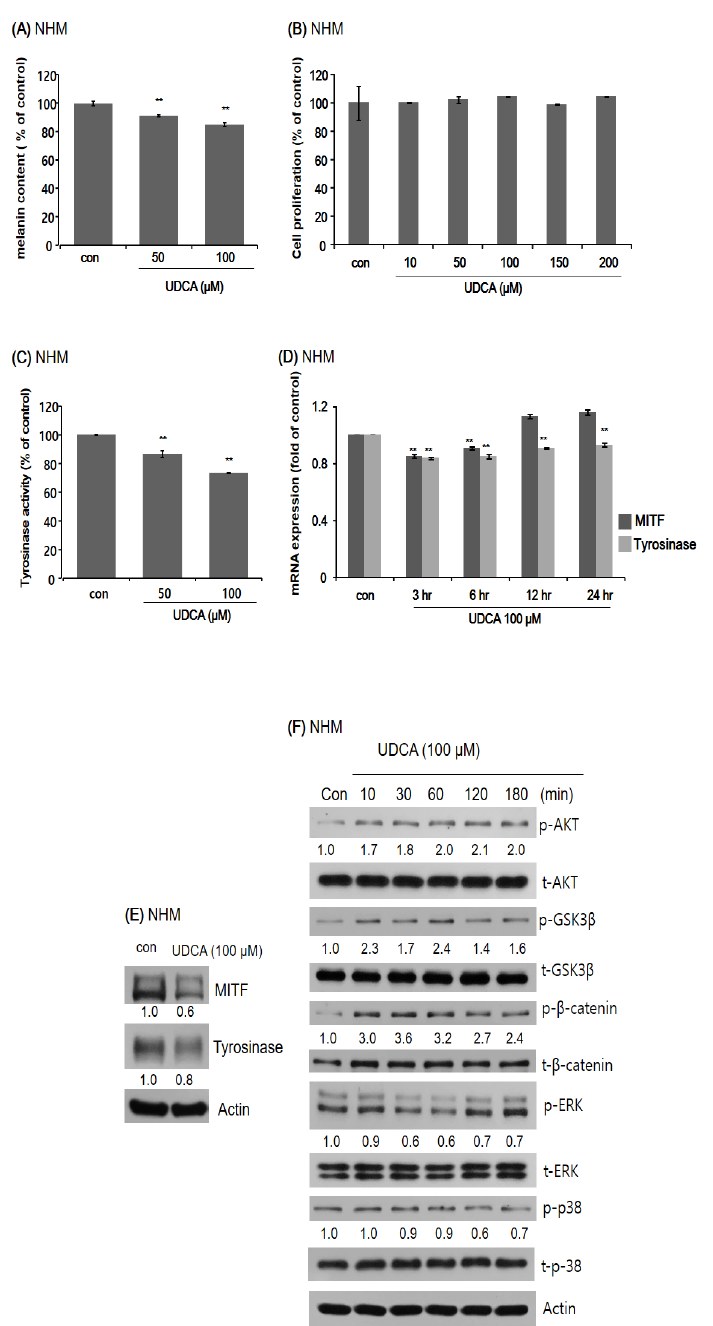
Figure 4. The effect of UDCA on normal human melanocytes (NHMs). ( A ) Treatment with 50 and 100 µ M UDCA resulted in decreased melanin content in NHMs. ( B ) NHMs were treated with different concentrations of UDCA from 10 µ M to 200 µ M. Cell proliferation was not affected by the tested concentrations of UDCA. ( C ) Treatment with 50 and 100 µ M resulted in decreased tyrosinase activity in NHMs. ( D ) Expression of MITF and tyrosinase in NHMs. Treatment with 100 µ M UDCA effectively lowered the mRNA expression levels of both MITF and tyrosinase starting from 3 h after treatment. By 12 h after treatment, recovery of mRNA expression of MITF was observed whereas that of tyrosinase suppressed until 24 h after treatment. ( E ) The results of Western blotting show decreased levels of both MITF and tyrosinase following UDCA treatment at 24 h. ( F ) Effect of UDCA treatment on the expression of melanogenesis-related signaling proteins in NHMs. Treatment with 100 µ M UDCA resulted in increased levels of p-AKT, p-GSK3 β , and p- β -catenin, and decreased levels of p-ERK and p-p-38. ** p < 0.01 compared with the non-UDCA-treated